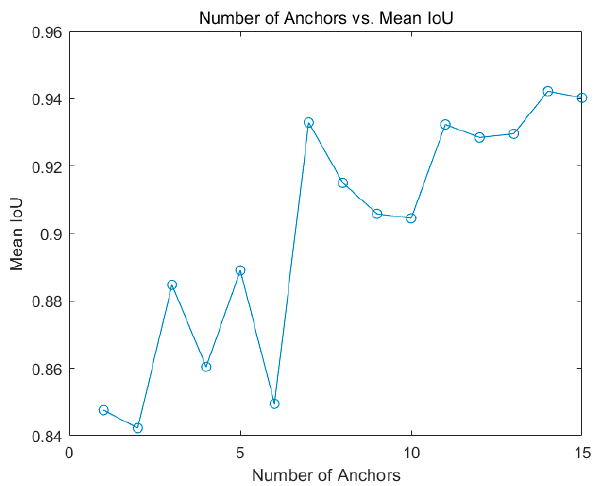
Figure 4. Mean IoU of number of anchors for garlic images.